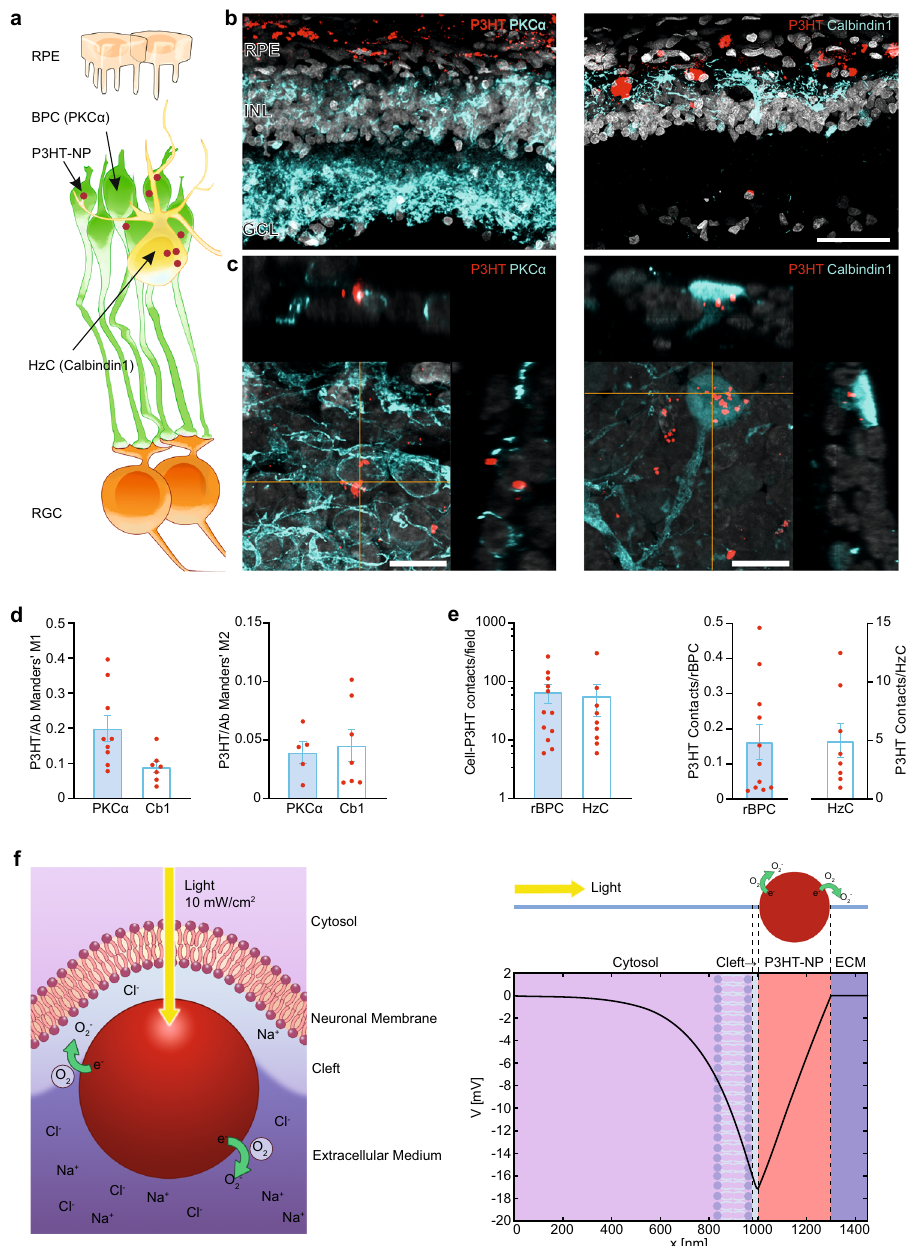
Fig. 3 P3HT-NPs form hybrid contacts with bipolar and horizontal cells. a Schematic representation of second-order retinal neurons. rBPCs and HzCs were identi fi ed by immuno fl uorescence targeting the speci fi c markers PKC α and Calbindin1, respectively. b Representative transverse sections of 13/15- month-old P3HT-NP injected RCS animals stained for rBPCs or HzCs (blue). The P3HT-NPs intrinsic fl uorescence is in red. Scale bar, 50 μ m. c Representative z-max projections with x - and y -orthoslices of super-resolution confocal images showing close contacts of P3HT-NPs with rBPCs and HzCs. Scale bar, 10 μ m. d Bar plots (means ± sem with individual data points) showing Manders ’ M1 (expressing the proportion of the total P3HT fl uorescent area colocalizing with rBPC/HzC immunoreactive area) and M2 (expressing the proportion of the total rBPC/HzC immunoreactive area colocalizing with the P3HT-positive area) coef fi cients for both markers. Values were thresholded at 0.01. M1: n = 9 (PKC α ) and 7 (Cb1); M2: n = 5 (PKC α ) and 7 (Cb1). e Average number of NP clusters contacting rBPCs and HzCs per fi eld and per average rBPC and HzC count. Data are shown as means ± sem with individual experimental points. b – e Sample size: 12 (rBPC), 9 (HzC) per fi eld; n = 11 (rBPC), 8 (HzC) per cell. rBPC, rod bipolar cell; HzC, horizontal cell. f Left: Schematics of a P3HT-NP microenvironment comprising the nanoparticle ( red ), the cleft (light blue) and the extracellular environment ( purple ). Due to the extreme ly narrow cleft (<20 nm), the bulk of the extracellular electrolyte is excluded from the NP-neuronal membrane junction. Right: Electric potential across the 1D computational domain comprising the cleft, the NP and the extracellular medium. Light naturally entering the eye hits the NP from the cleft side in which the NP contacts second-order retinal neurons. Source data are provided for panel d , e as a Source data fi